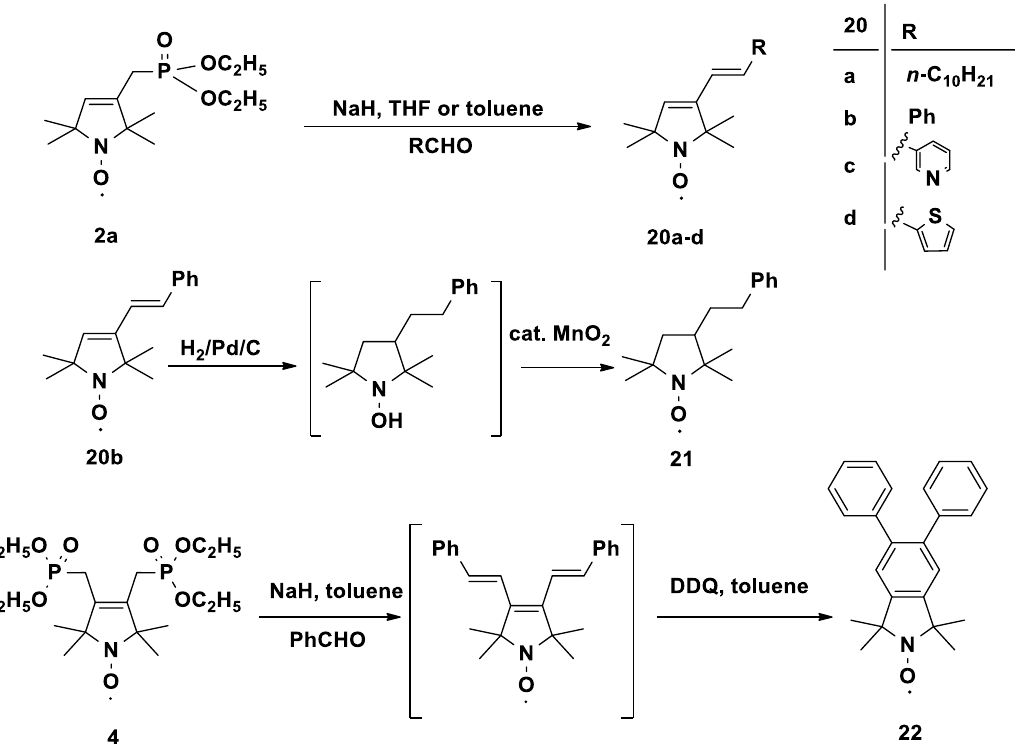
Table 1. TEAC activity of phosphonates.